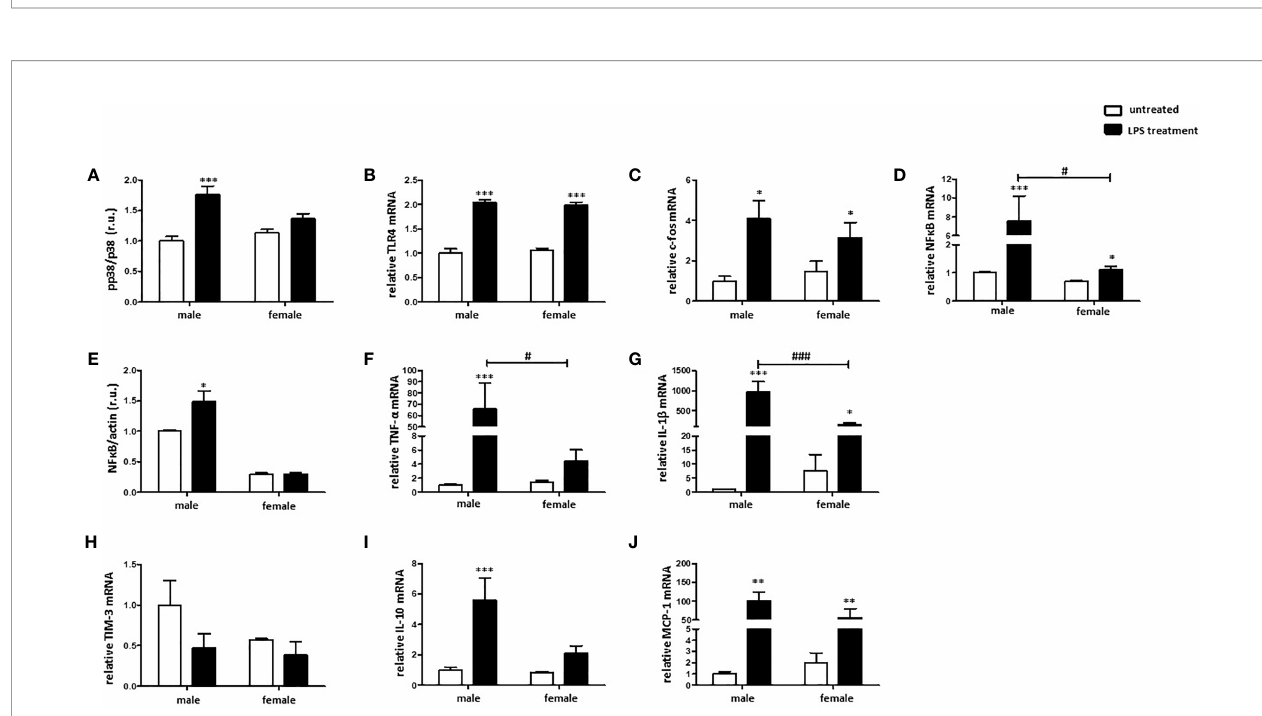
FIGURE 3 | LPS elicits stronger pro-in fl ammatory response in male than in female BMMs. Expression analyses of (A) pp38/p38 ratio, (B) TLR4 mRNA, (C) c-fos mRNA, (D) NF k B mRNA, (E) NF k B protein, (F) TNF- a mRNA, (G) IL-1 b mRNA, (H) TIM-3 mRNA, (I) IL-10 mRNA, and (J) MCP-1 mRNA performed with bone marrow macrophages lysates from male and female mice treated with 10 ng/ml LPS for 24 h. Data are shown as means ± SEM (n = 9; independent experiments with technical duplicates). Data are normalized to the male untreated group and expressed in relative units (r.u.). *p < 0.05, **p < 0.01, ***p < 0.001, untreated vs. treated; # p < 0.05, ### p < 0.001, male vs.